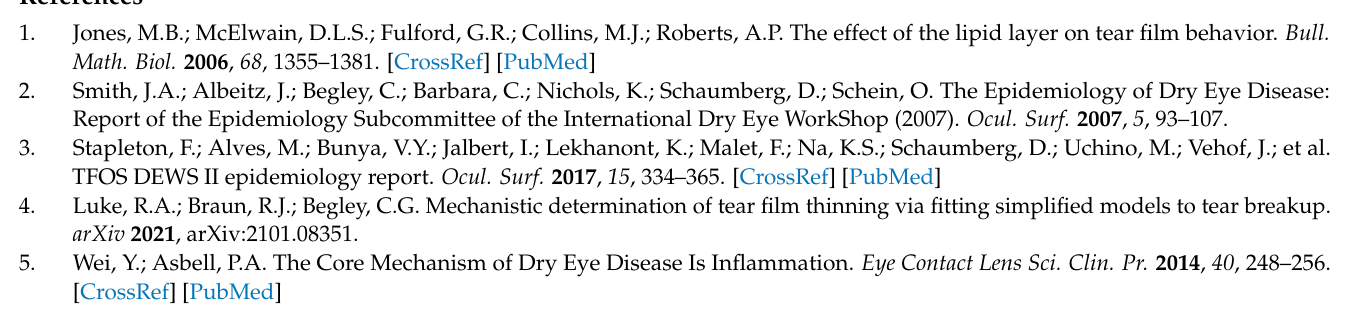
Figure 11. Model validation against the model by Aydemir et al.’s work [24]. ( a , b ) film thickness distribution along the planar subtract at 0.04 and 0.18 sec, respectively. ( c ) Evolution of the minimum tear film thickness with time. The parameters of the simulations are: ρ = 10 3 kg · m − 1 , µ = 1.3 × 10 − 3 Pa.s, σ = 0.045 N/m, h* = 0.001 m, L cl = 0.002 m, L op = 0.01 m, U 0 = 0.0163